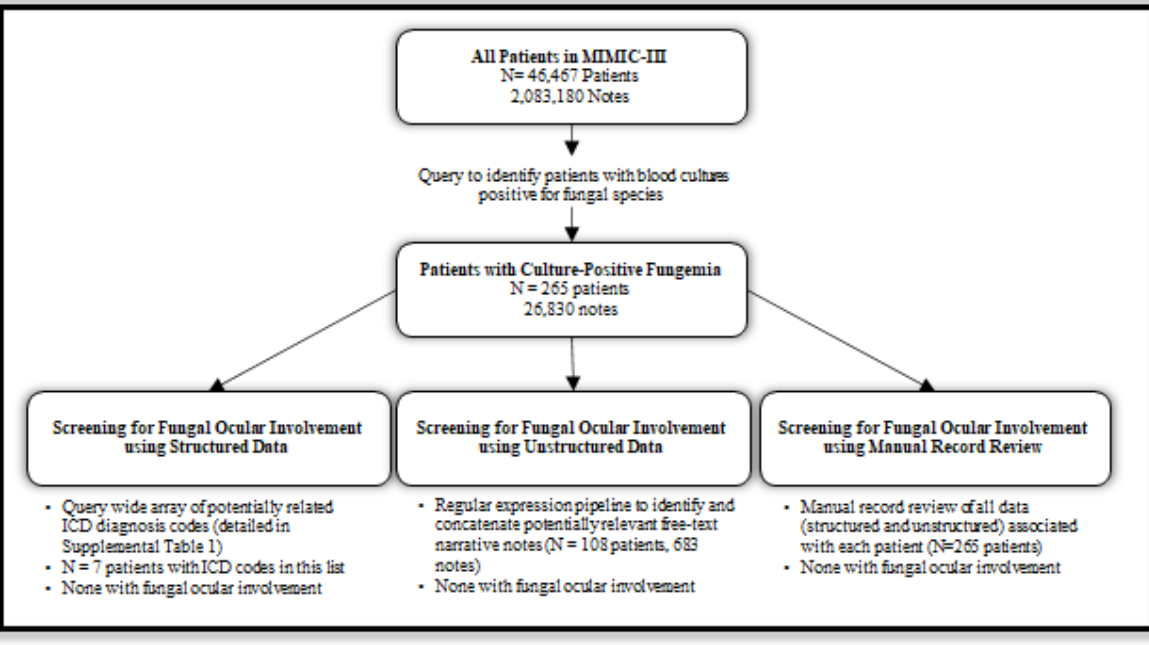
Figure 1. Screening for fungal ocular involvement using approaches leveraging structured and unstructured data within the Medical Information Mart